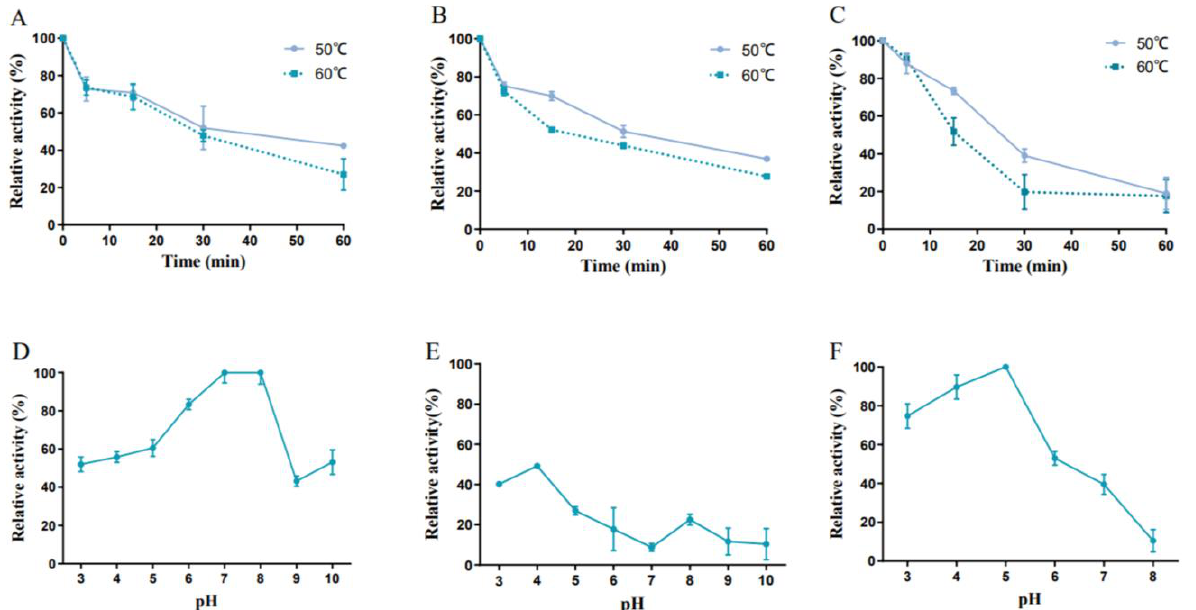
Figure 12. Characterization of purified recombinant enzymes. ( A ) Thermostability of FumTSTA; ( B ) Thermostability of FumPHTA; ( C ) Thermostability of FumUPTA; ( D ) pH stability of FumTSTA; ( E ) pH stability of FumPHTA; ( F ) pH stability of FumUPTA.